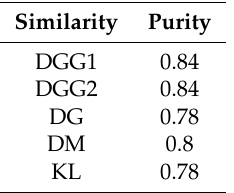
Figure 1. General scheme of the proposed approach. Table 2. Performance of clustering with different similarity